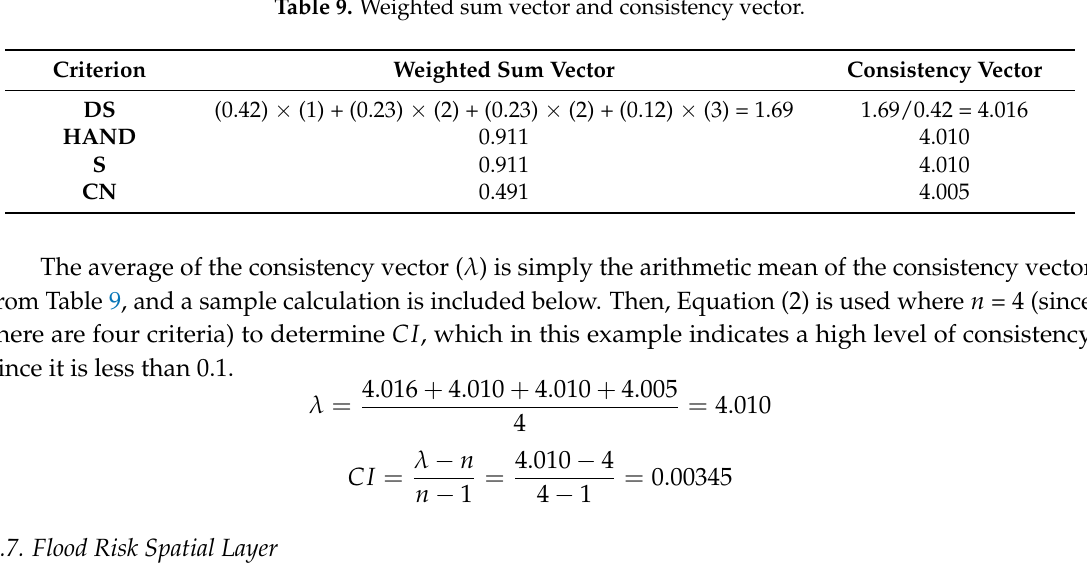
Table 9. Weighted sum vector and consistency